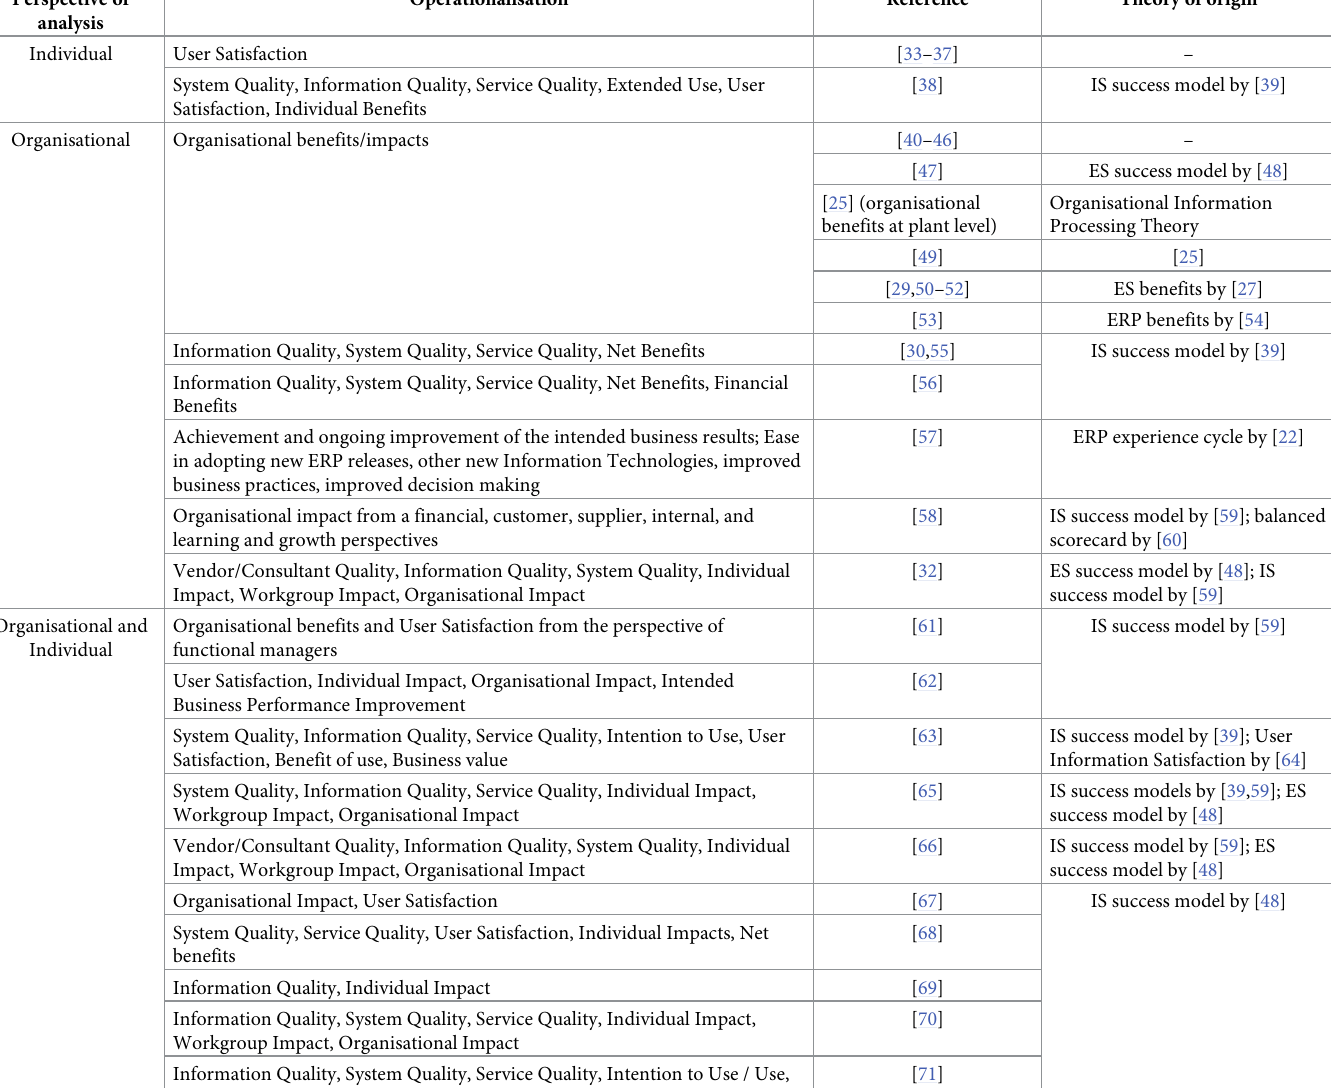
Table 1. Classification of the ERP post-implementation success scientific